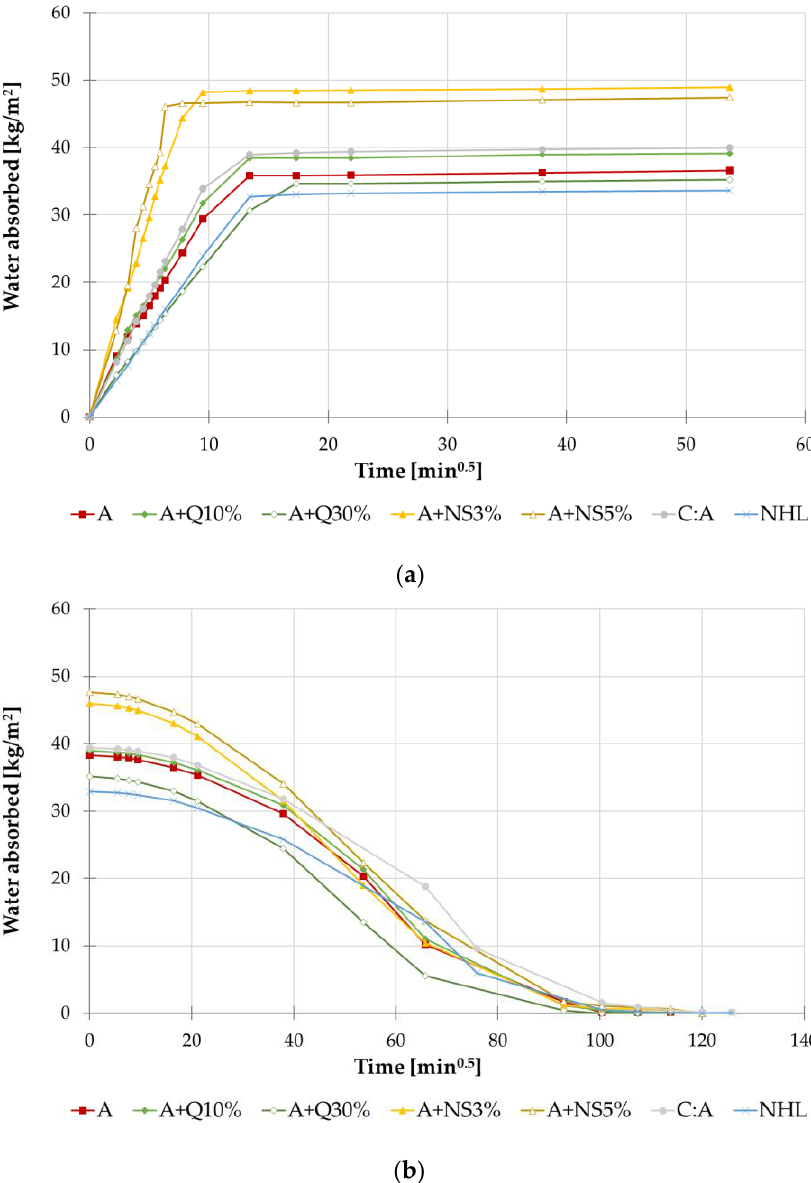
Figure 9. Capillary water absorption curves of the mortars with siliceous sand at 90 days: ( a ) water absorption; ( b ) water desorption.